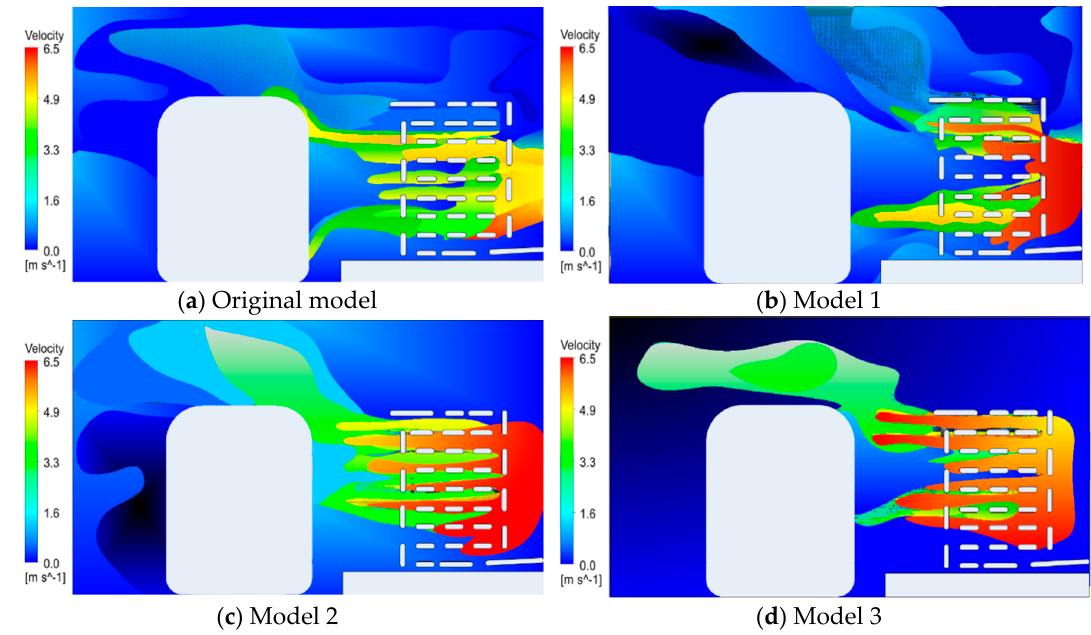
Figure 15. Velocity plots of vertical section at +40 mm position from the center—front view.